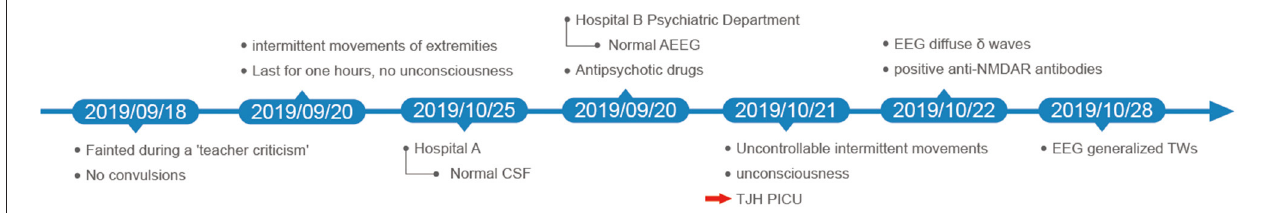
FIGURE 2 | Timeline of the clinical